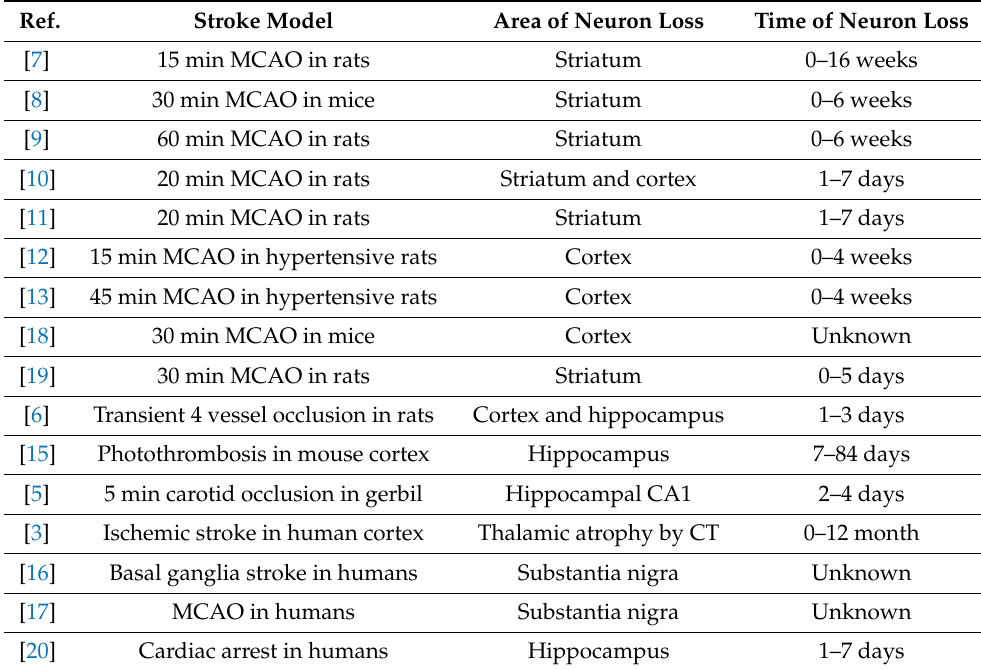
15 min MCAO in hypertensive